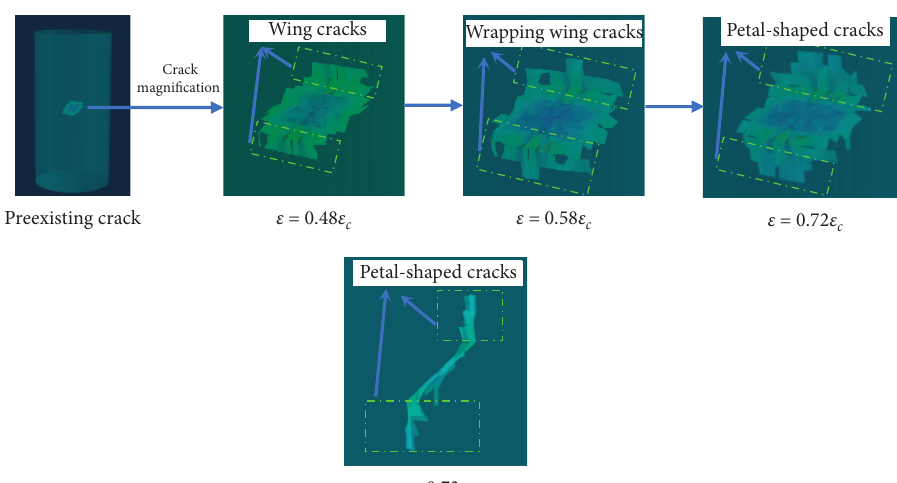
Figure 13: Calculation model and mesh